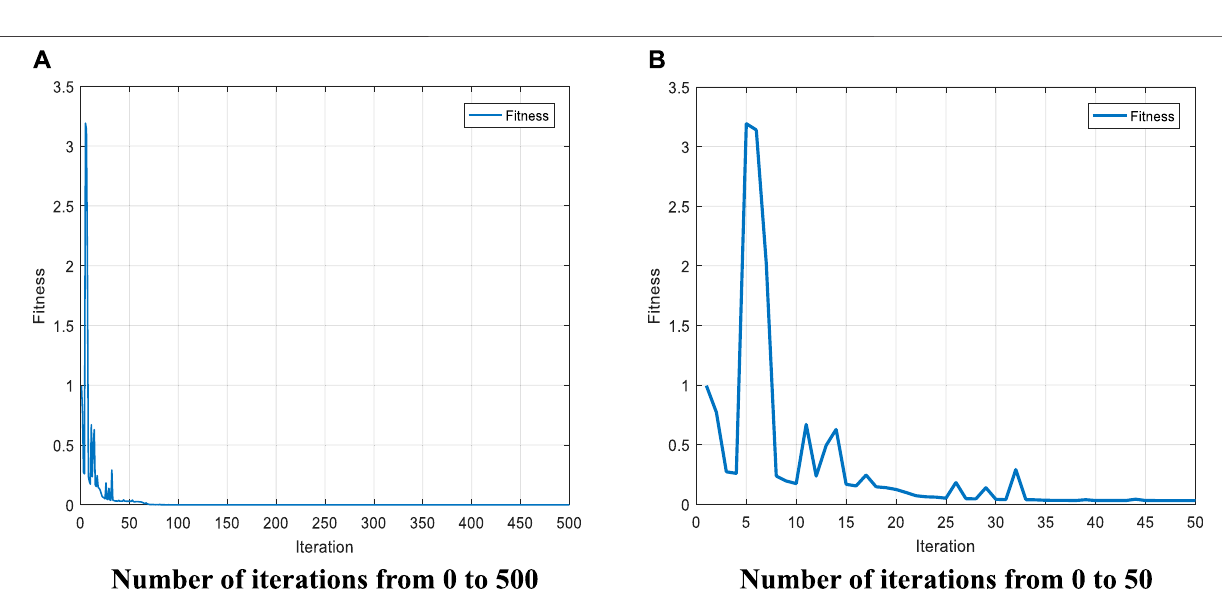
FIGURE 6 | Plot of the variation of the fi tness function with the number of